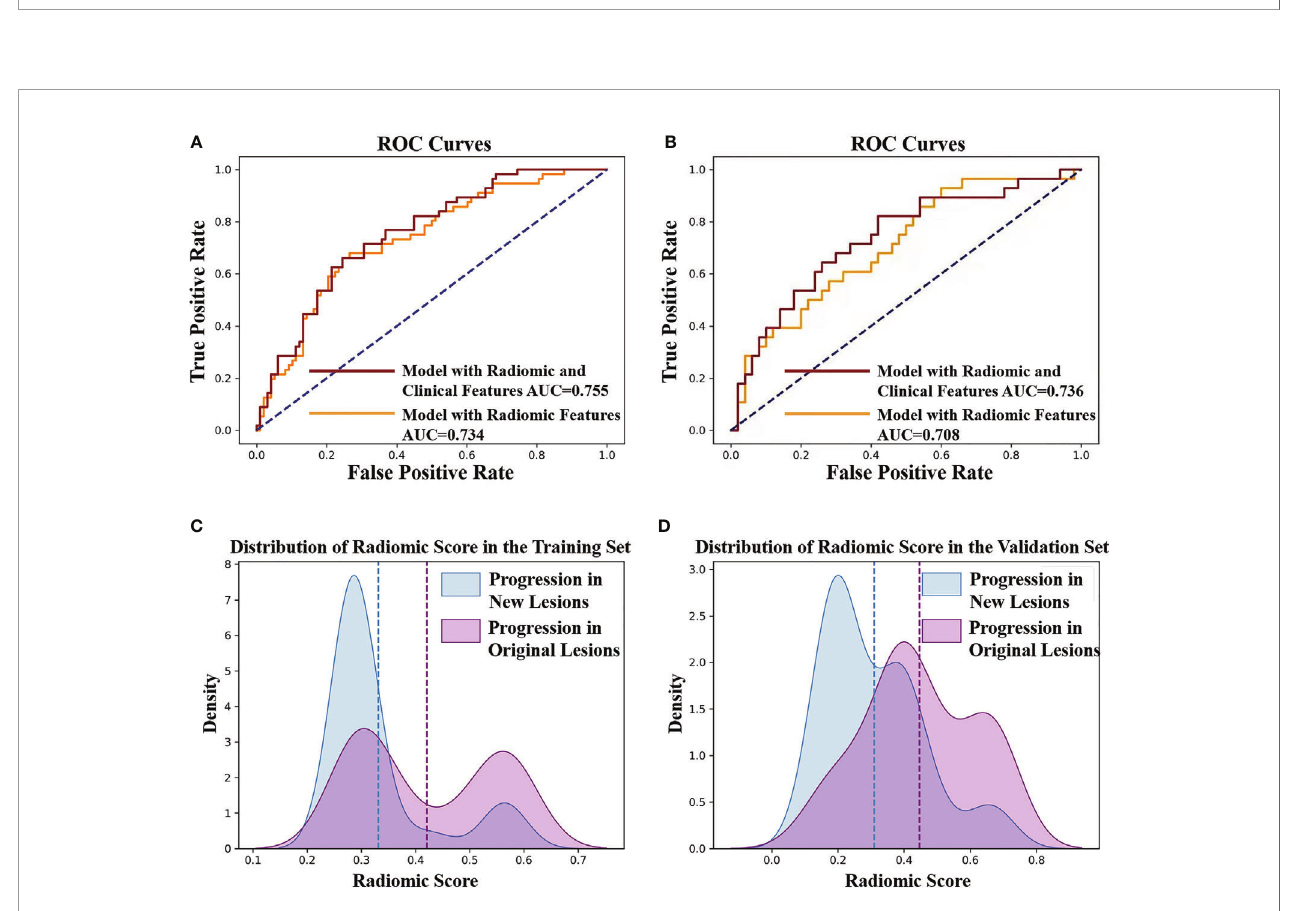
FIGURE 6 | (A) ROC curves of the radiomic model to predict the progression sites in the training set. The AUC value of the model with radiomic features is 0.734 (yellow line). The AUC value of the model with radiomic features and clinical features is 0.755 (red line). (B) ROC curves of the radiomic model to predict the progression sites in the validation set. The AUC value of the model with radiomic features is 0.708 (yellow line). The AUC value of the model with radiomic features and clinical features is 0.736 (red line). (C) The predicted radiomic score for progression in original lesions (OP) and progression in new lesions (NP) is 0.421 ± 0.125 and 0.331 ± 0.097, respectively, in training set. (D) The predicted radiomic score for OP and NP is 0.447 ± 0.164 and 0.310 ± 0.146, respectively, in the validation set.